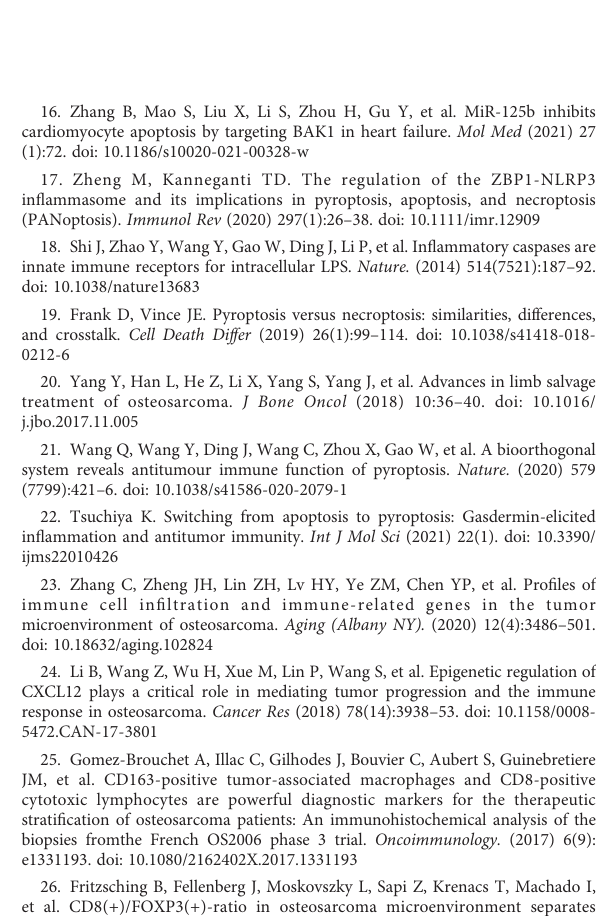
SUPPLEMENTARY FIGURE 2 (A) PRG score distribution and survival status in ranked dot and scatter plots in the testing group. (B) The expression heatmap of 5 gene signature in the testing group. (C) Kaplan – Meier analysis of the survival between the high- and low-risk groups in the testing group. (D) The prognostic accuracy of the risk scores in the testing group was veri fi ed by ROC curve. (E) PRG score distribution and survival status in ranked dot and scatter plots in the all group. (F) The expression heatmap of 5 gene signature in the all group. (G) Kaplan – Meier analysis of the survival between the high- and low-risk groups in the all group. (H) The prognostic accuracy of the risk scores in the all group was veri fi ed by ROC curve. SUPPLEMENTARY FIGURE 3 (A – H) Correlations between PRG_score and immune cell types. SUPPLEMENTARY FIGURE 4 Relationships between PRG_score and chemotherapeutic